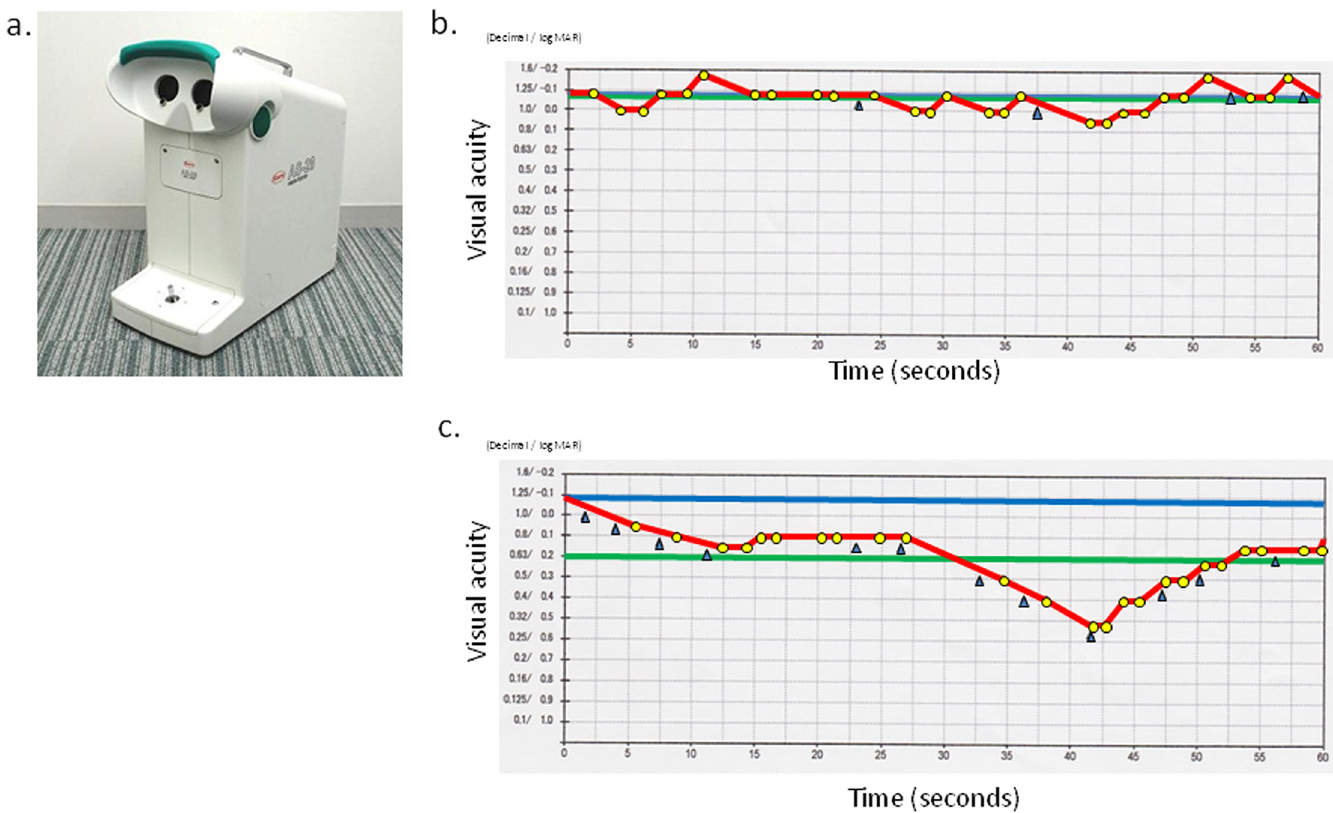
Fig 1. FVA Measurement System and results of typical cases. (A) FVA Measurement System (AS-28, Kowa). (B) Representative printout of a typical case with good FVA. The blue line denotes the Landolt corrected VA. The red line shows the time-wise changes in the VA during testing. The green line denotes the mean logMAR VA during 60 seconds, defined as the FVA. The yellow dots indicate the number of correct responses and the blue arrows indicate spontaneous blinks. FVA (logMAR), -0.08; VMR, 0.99; max/min logMAR VAs, -0.18/0.05, respectively; ART, 1.47 seconds. (C) Representative printout of a typical case with low FVA. FVA (logMAR), 0.19; VMR, 0.83; max/min logMAR VA, 0.05/0.52, respectively; ART, 1.46